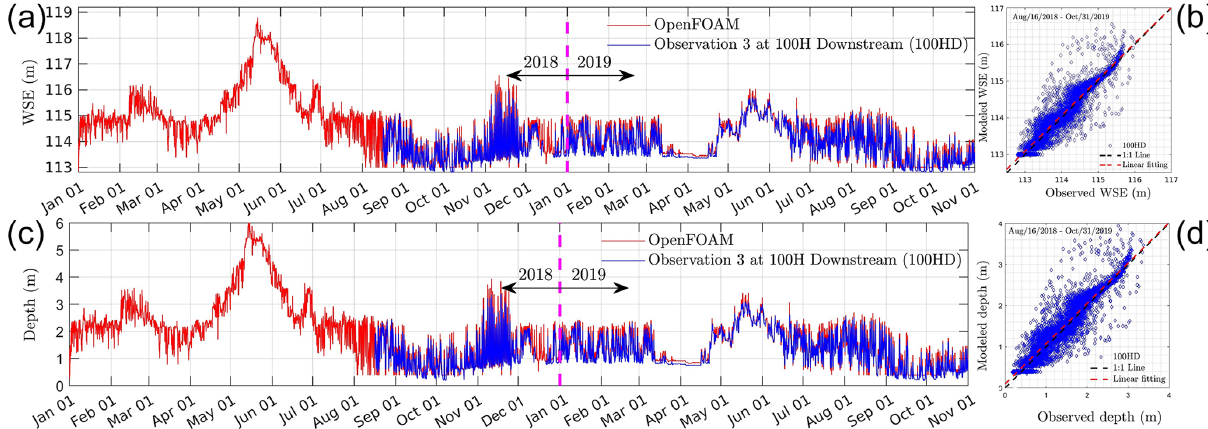
Figure 10. Long-term model validation for water surface elevation and depth. A comparison of the hourly recorded WSE and depth from model and observations at 100HD during 2018–2019 (a, c) and their 1 : 1 plots (b, d)